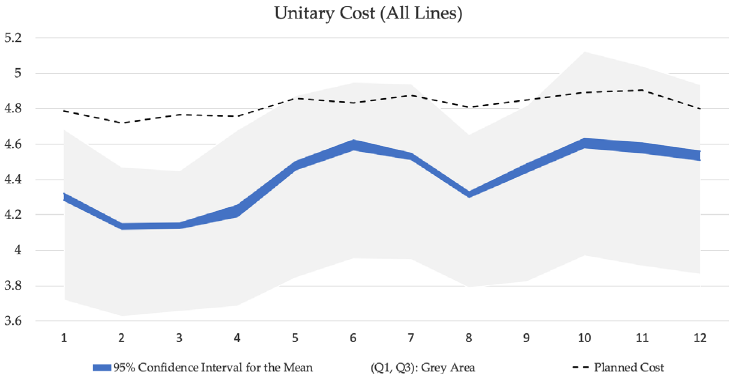
Figure 7. Stochastic product cost analysis. Values in euros for each of the 12 weeks.